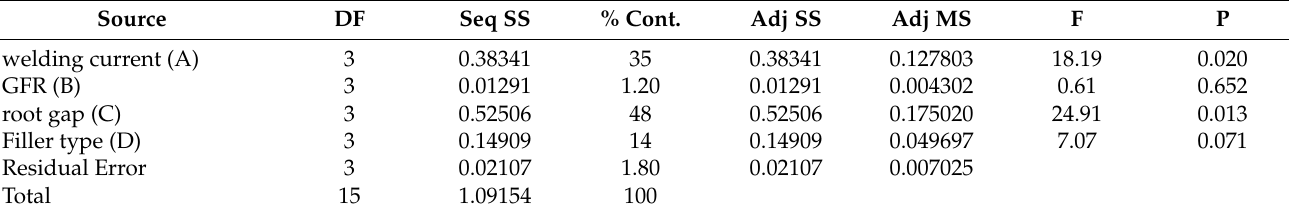
Table 27. Analysis of variance of dg.